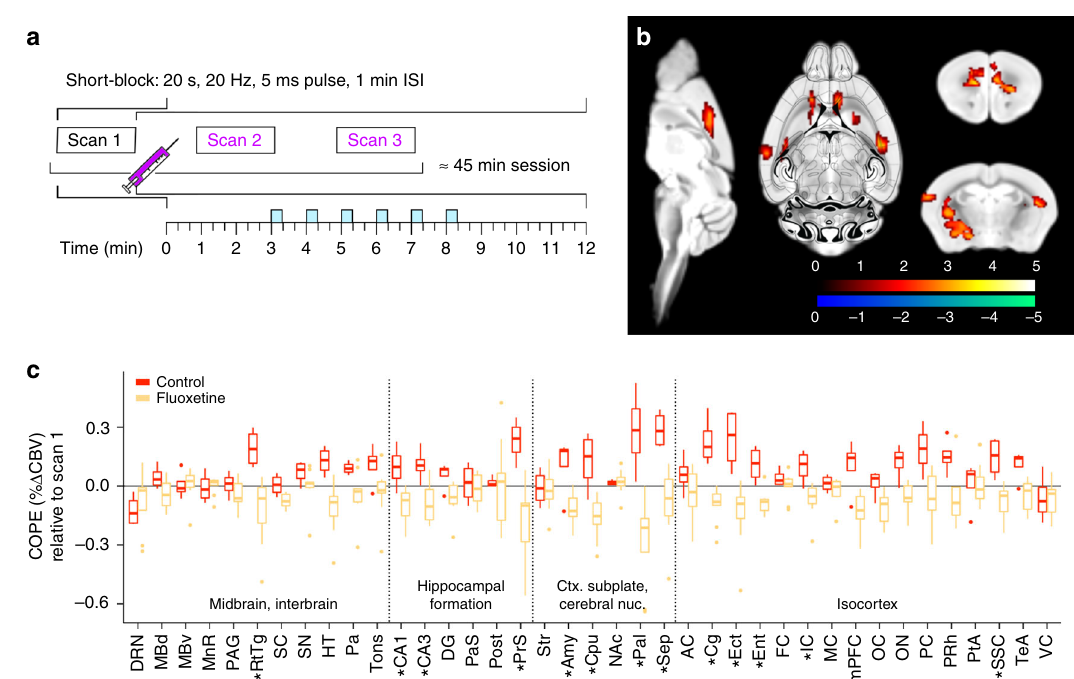
Fig. 5 Circuit regulation of DRN 5-HT functional connectivity by fl uoxetine. a Experiment schematic. b Second level analysis comparing fl uoxetine ( n = 9) to control ( n = 4) condition indicate an increase in negative response amplitude in scan 2 and 3 relative to scan 1 in the prefrontal, cingulate and peri- hippocampal cortex, as well as amygdala and parts of the striatum, in the fl uoxetine group. Colour scale = t -statistic (non-parametric test, p ≤ 0.05, cluster corrected), red-yellow colour bar indicating signi fi cance for fl uoxetine < control comparison; see Supplementary Figure 15 for all brain slices. c COPEs comparing fl uoxetine (yellow) and control (red) con fi rm an augmentation of the decreased response amplitudes in CBV within regions highlighted by the voxel-wise analysis (* p < 0.05, FDR corrected). Bound of box and centre line represent 25th, 50th, 75th percentiles, whiskers represent